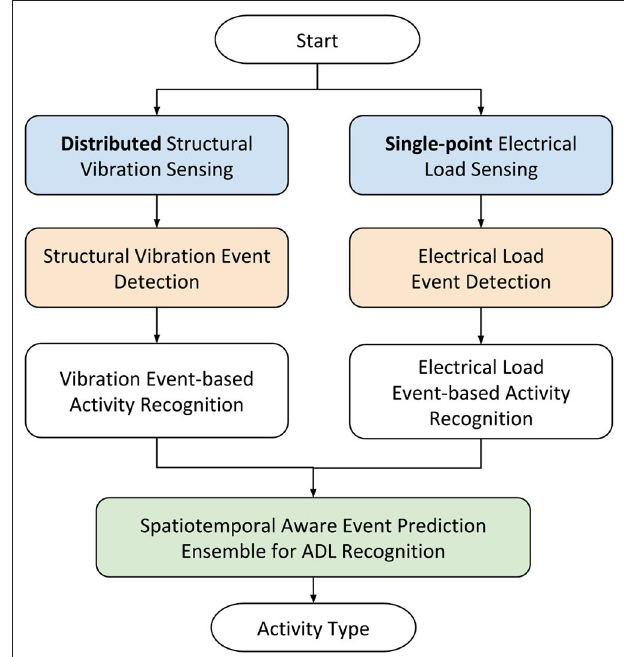
FIGURE 1 | System overview.